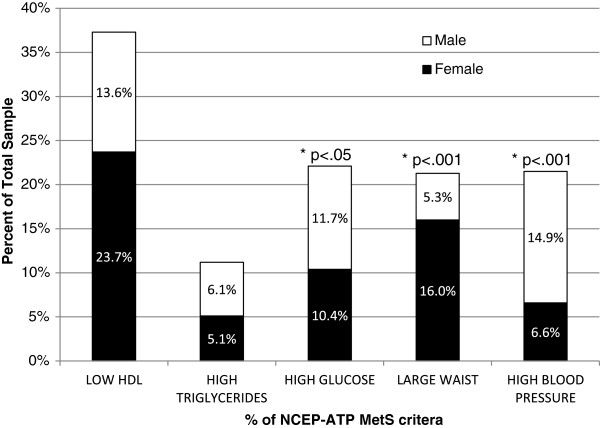
Percentage of NCEP-ATP MetS criteria by gender. Data analyzed using Crosstabs Procedure, Pearson Chi-Square test for significance, non-Parametric Independent t-test. Female n=218; Male n=158. *p ≤ 0.05.